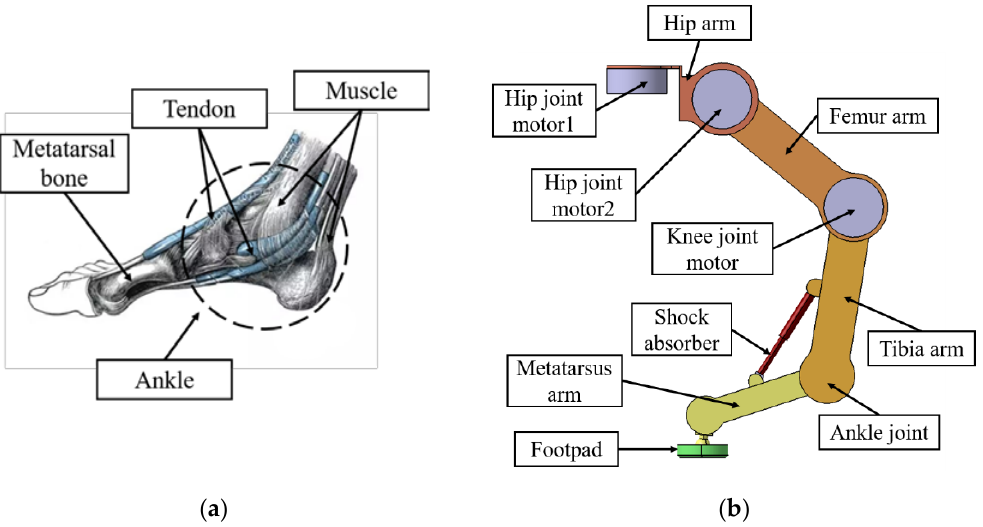
Figure 1. Comparative diagram of the human foot and landing leg: ( a ) represents the anatomical view of the foot and ankle; ( b )represents the structure of a single leg of the adaptive landing gear.